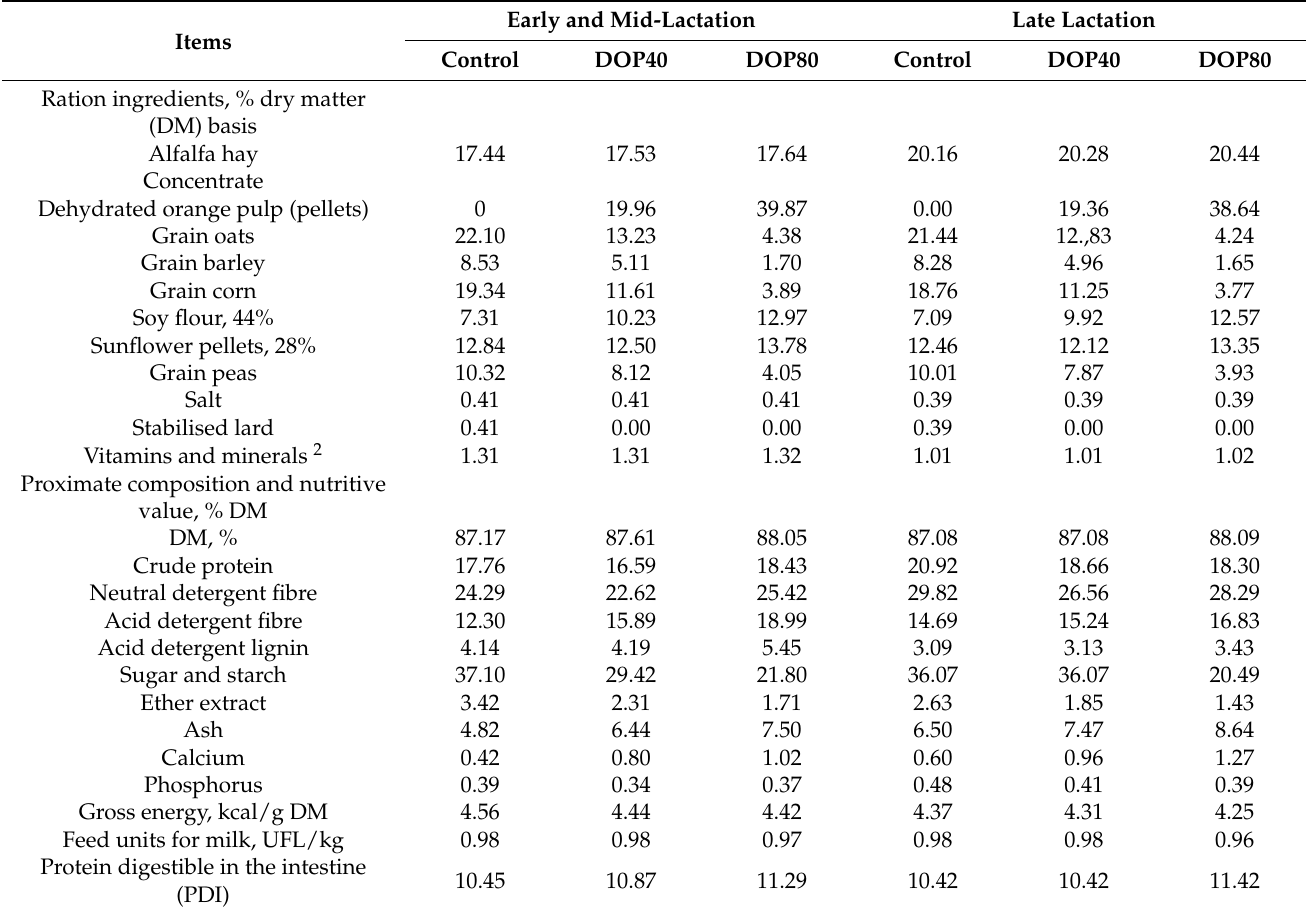
Table 1. Ration ingredients and proximate composition of the experimental diets 1 during the entire lactation